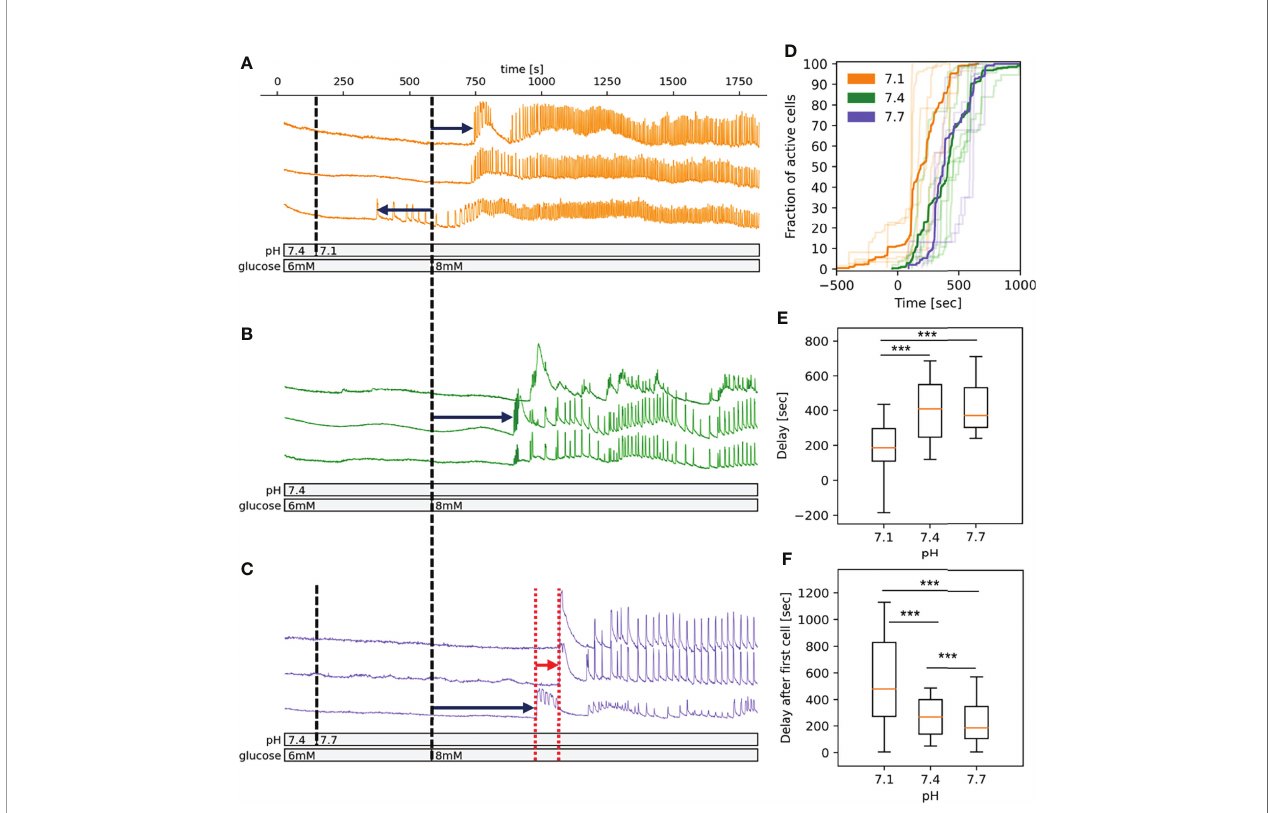
FIGURE 1 | pH-dependency of activation of beta cells in islets in fresh pancreatic slices. (A) Time course of the [Ca 2+ ] c oscillations in a selection of beta cells exposed to pH 7.1 for 10 min followed by stimulatory glucose concentration (8 mM). Dark blue arrows indicate the delay time from introduction of stimulatory glucose to activation and red arrow indicates the time of delays from activation of fi rst cell to the activation of every other cell. (B) As panel A at pH 7.4 (C) As panel A at pH 7.7. (D) Pooled data showing the fraction of active cells in time. The acidi fi cation induces a left shift of activation curve. Semi-transparent lines show results of the individual experiments, bold lines are the averages for each experimental condition. (E) Quanti fi cation of pooled data of delays from introduction of stimulatory glucose to activation. (F) Quanti fi cation of pooled data of delays from activation of fi rst cell to the activation of every other cell. n=5 islets for each condition. Box plots are showing upper and lower quartile; line median; whiskers 5-95%. ***p <